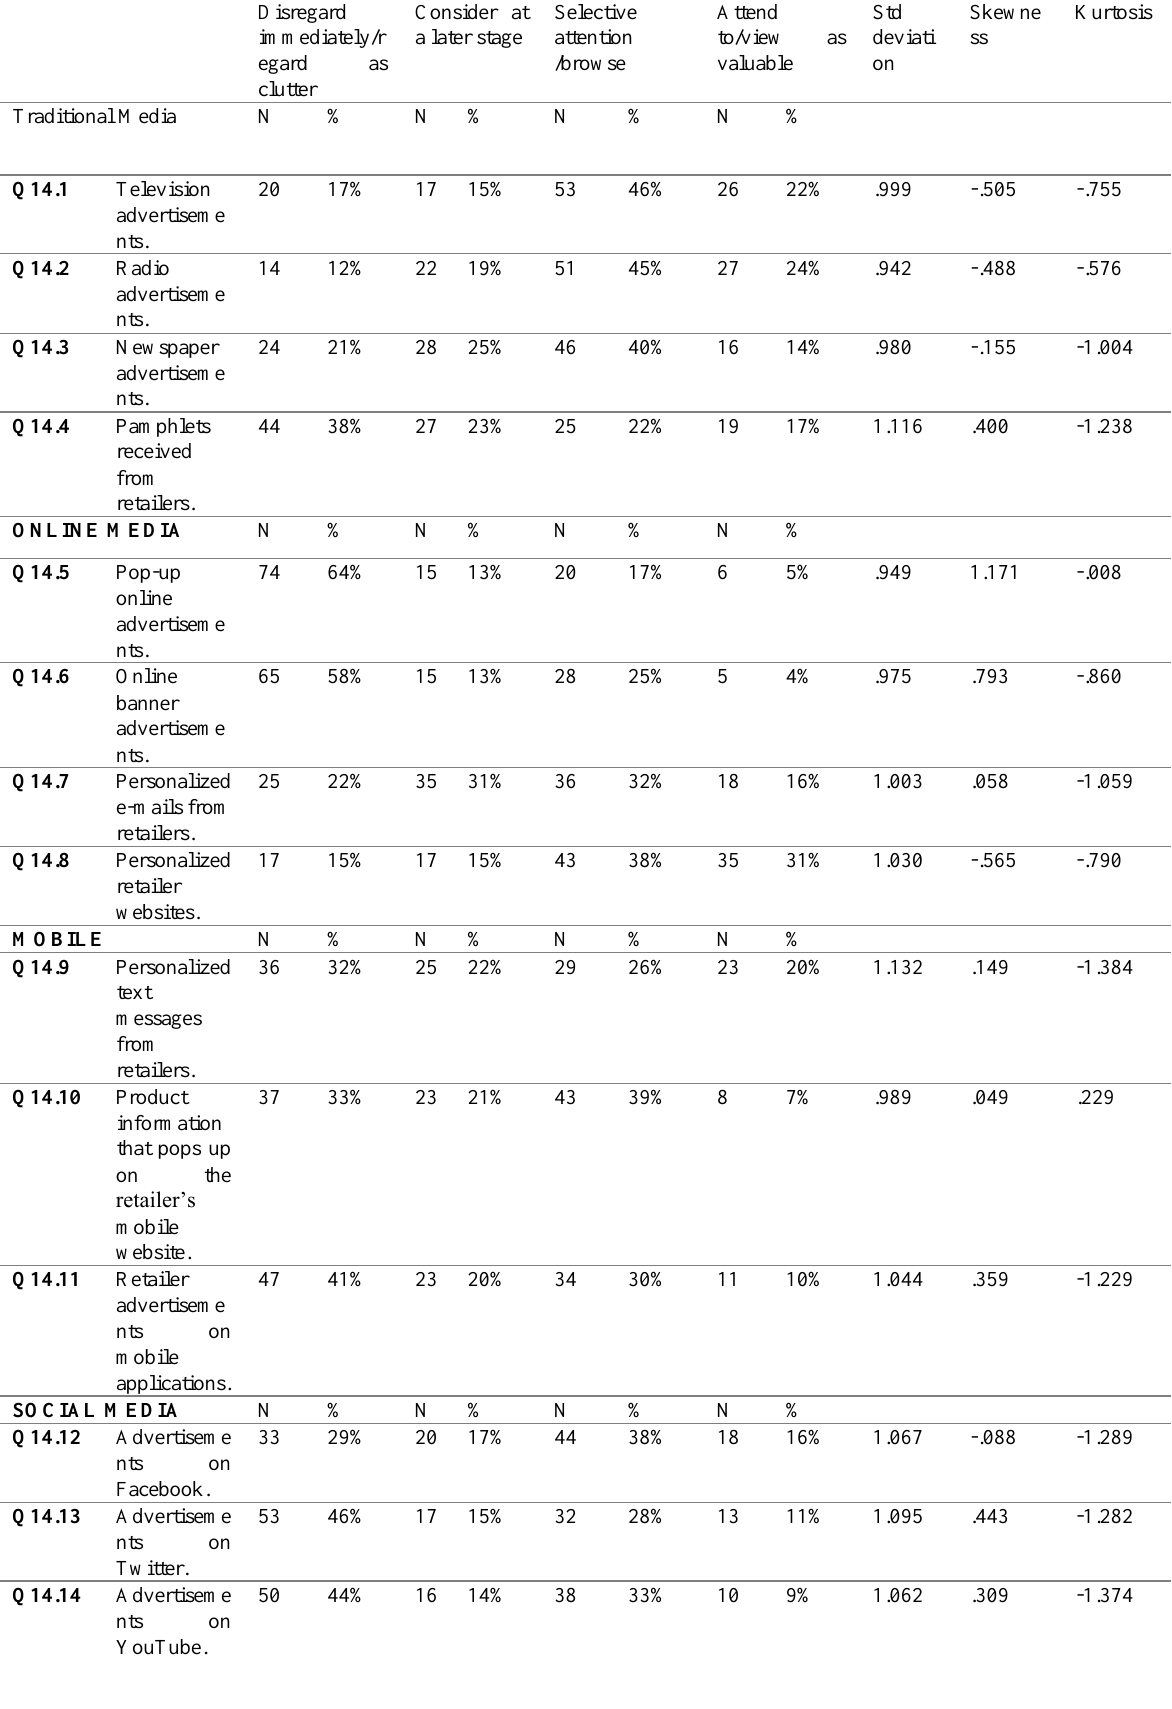
Consider at a later stage